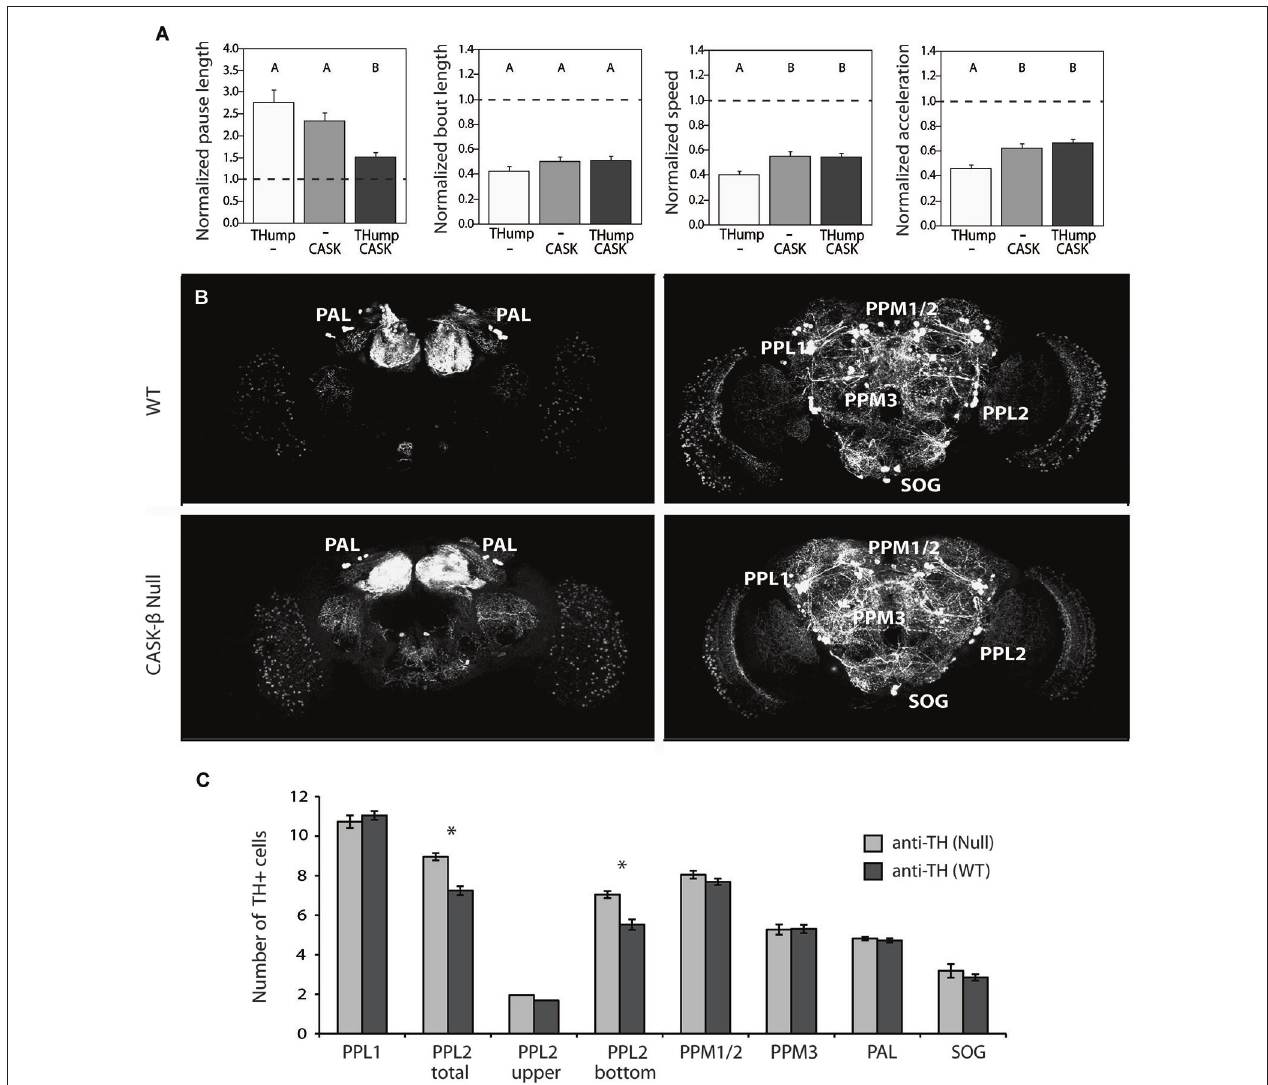
and “CASK” = UAS-CASK - β . All transgenes were on a CASK - β mutant background. Letters indicate significant differences between groups ( P < 0.05, ANOVA with Tukey HSD). See Section Methods for details on statistical tests. (B) Dopaminergic neurons were visualized with an anti-TH antibody using confocal imaging. (C) Cell counts of both WT brains (top panels, anterior and posterior are shown) and CASK- β null brains (bottom panels, anterior and posterior are shown) demonstrate equivalent numbers of dopaminergic neurons across most dopaminergic cell clusters between these two genotypes. Significant differences between WT and CASK - β mutant are represented by asterisks ( P < 0.05, Student’s t